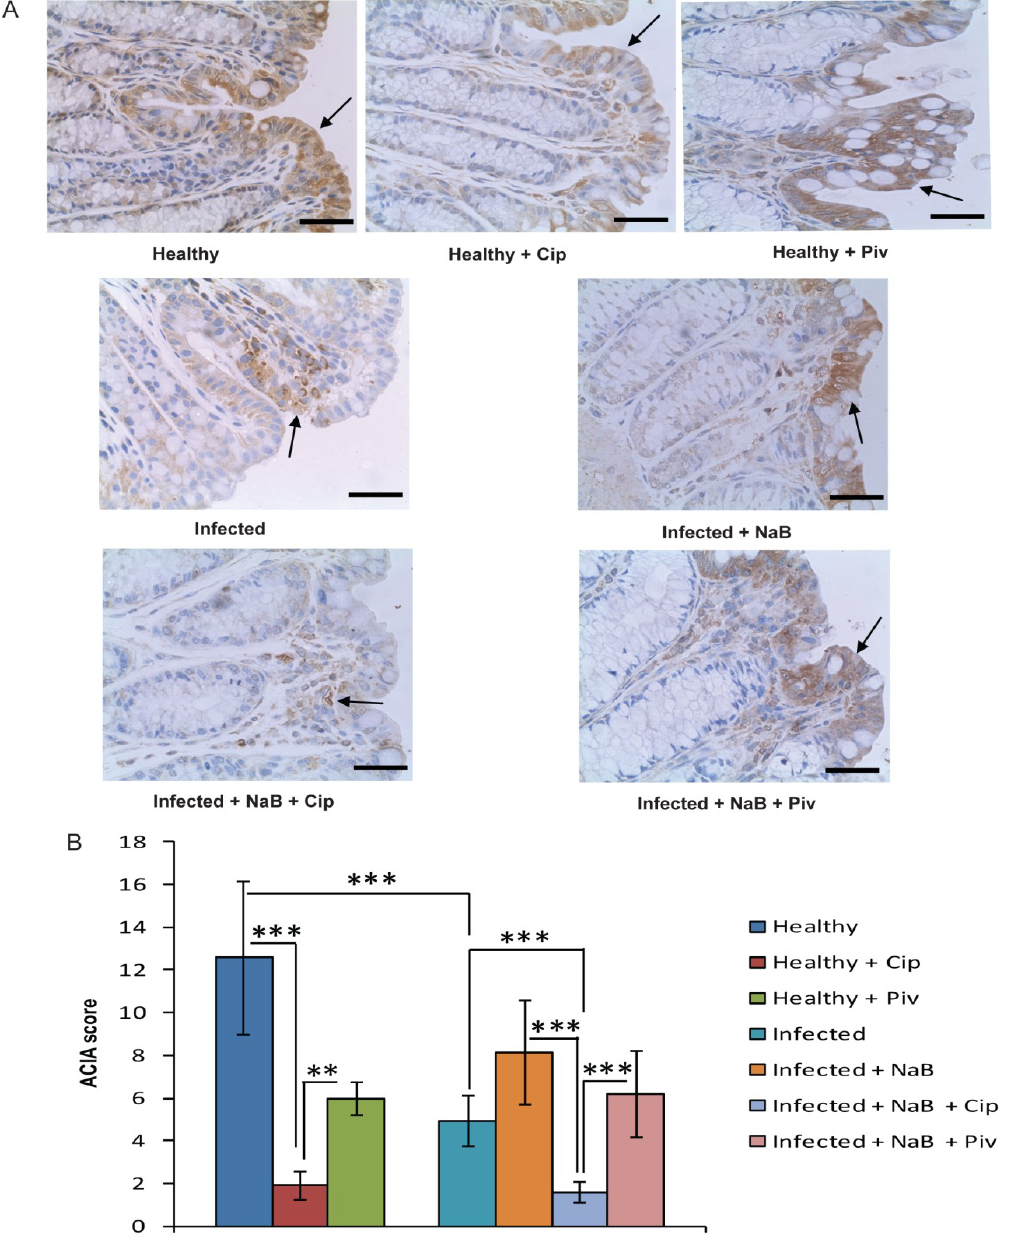
Figure 3. Effect of ciprofloxacin and pivmecillinam on CAP-18 expression in rectal epithelia of rabbit. Healthy rabbits were either treated with ciprofloxacin ( n = 3) or pivmecillinam ( n = 3) or left untreated ( n = 3). Shigella infected rabbits treated with 2 mM NaB alone ( n = 3) or together with ciprofloxacin ( n = 3) or pivmecillinam ( n = 3) or left untreated ( n = 3). Mucosal sections of rectum were stained with the rabbit cathelicidin CAP-18 specific antibody. ( A ) Representative photomicrographs of CAP-18 immunostaining (arrows). Bars equal to 50 µm; ( B ) Semi-quantification of CAP-18 immunostaining are expressed as ACIA score (See materials and methods). Data are given as mean ± standard deviation. One way ANOVA of log-transformed data was utilized in comparing between different groups. Pair-wise effects between different groups were compared by the Holm-Sidak post hoc comparison procedure. ** p < 0.01, *** p < 0.001. NaB: sodium butyrate; Cip: ciprofloxacin; Piv: